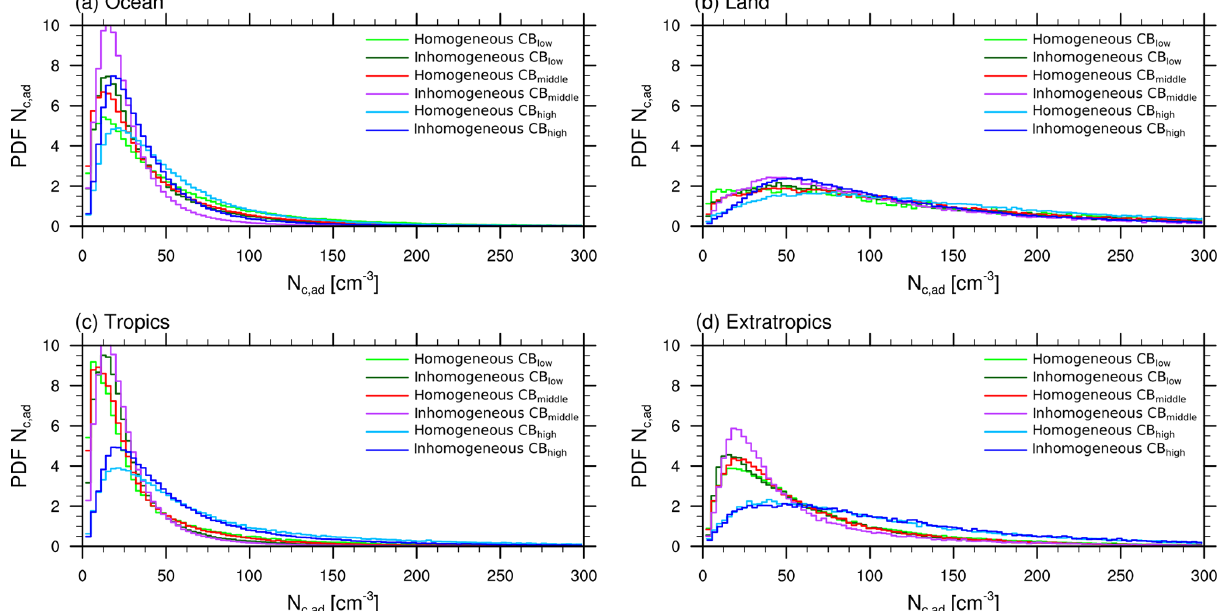
Figure A1. As Fig. 4a, but separately for (a) ocean, (b) land, (c) the tropics (20 ◦ S–20 ◦ N) and (d) the extratropics (40 ◦ S–60 ◦ S and 40– 60 ◦